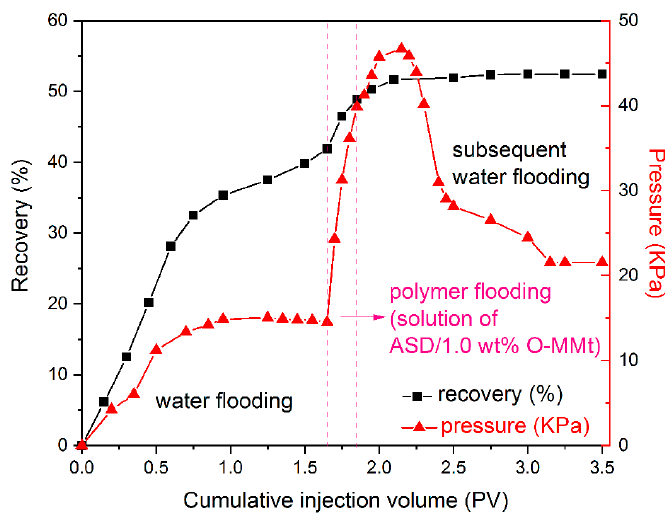
Figure 16. EOR experiments using ASD/1.0 wt% O-MMt under laboratory conditions. Table 4. EOR of ASD/1.0 wt% O-Mt.